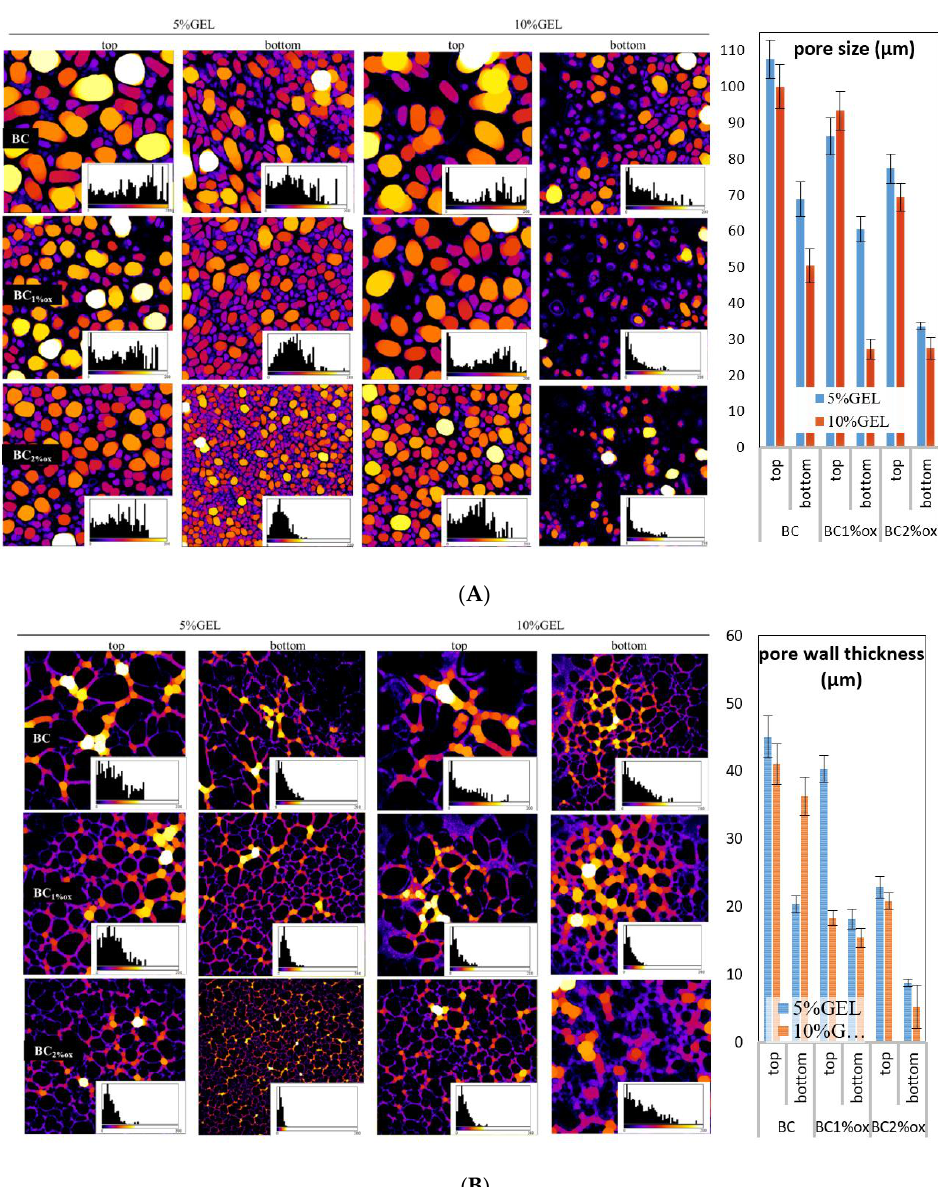
Figure 3. Color-coded images of BC–GEL membranes emphasizing pores ( A ) and pore walls ( B ). The image insets are respective histograms demonstrating normalized distributions of pore size and pore wall thicknesses within the tops and bottoms of membranes ( x axis: 0–200 µm, y axis: count) without and with 5% and 10% GEL, and (non)oxidized BC. Mean/SD data of pore size and pore wall thickness are presented next to respective ( A,B ) image sets.